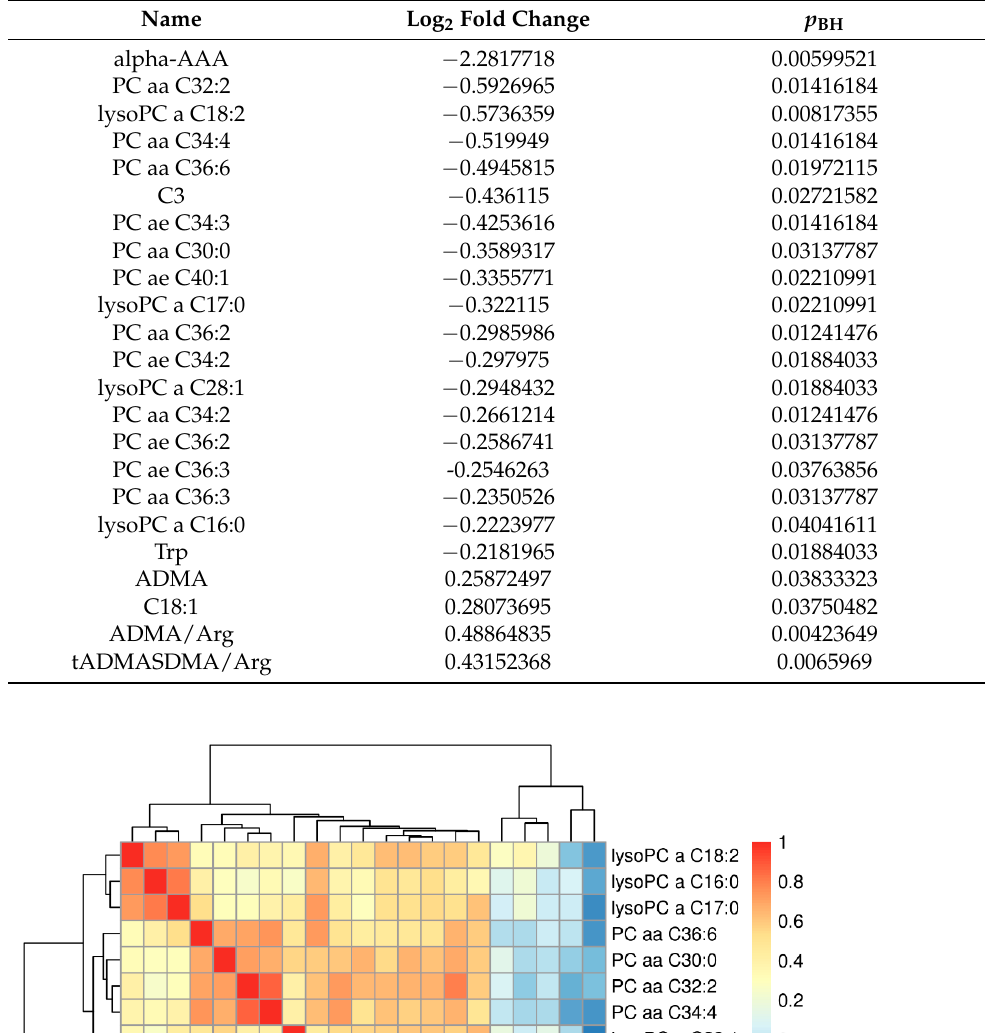
Table 2. List of the significant metabolites and ratios. The table shows the analyte name, the log2 fold change and the p -value adjusted for multiple hypothesis testing. Analytes were sorted by the difference in abundance.